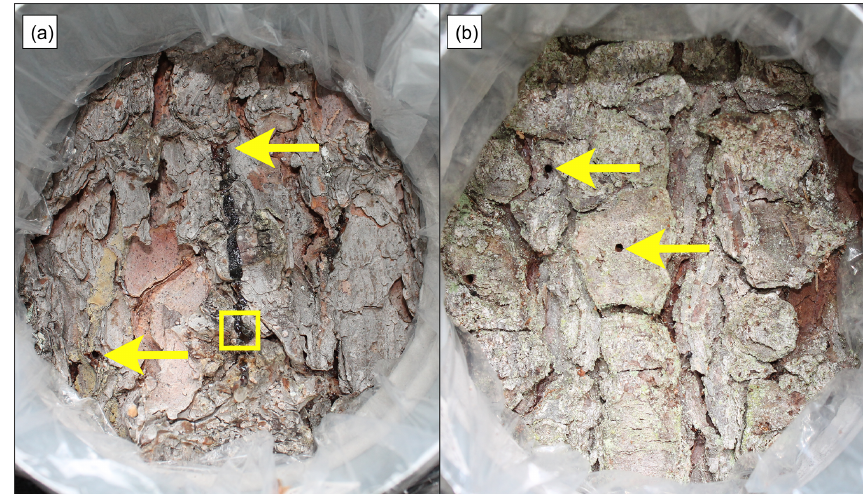
Figure 4. Examples of infested Norway spruce trees with (a) entry and (b) exit holes. The arrows indicate examples of bark-beetle-drilled holes, and the square box frames a bark beetle. There are more holes in the pictures than indicated by the